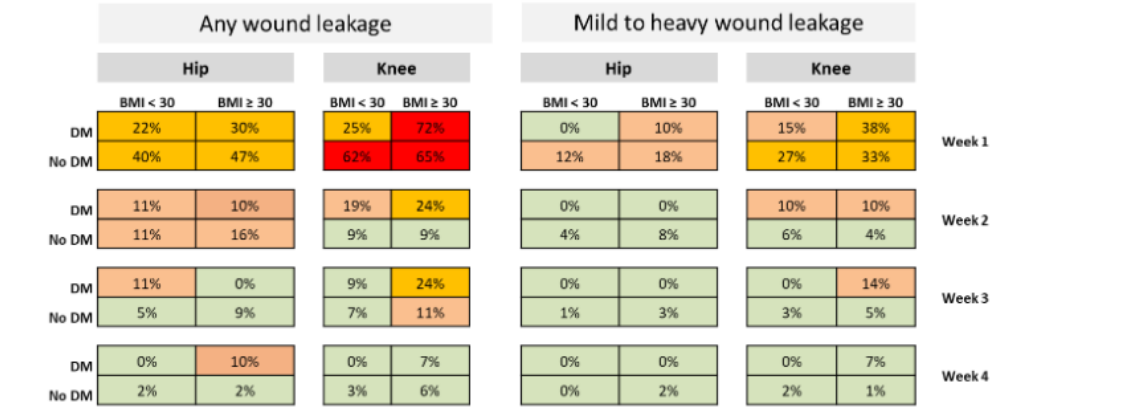
Legend: BMI – body mass index; DM – diabetes